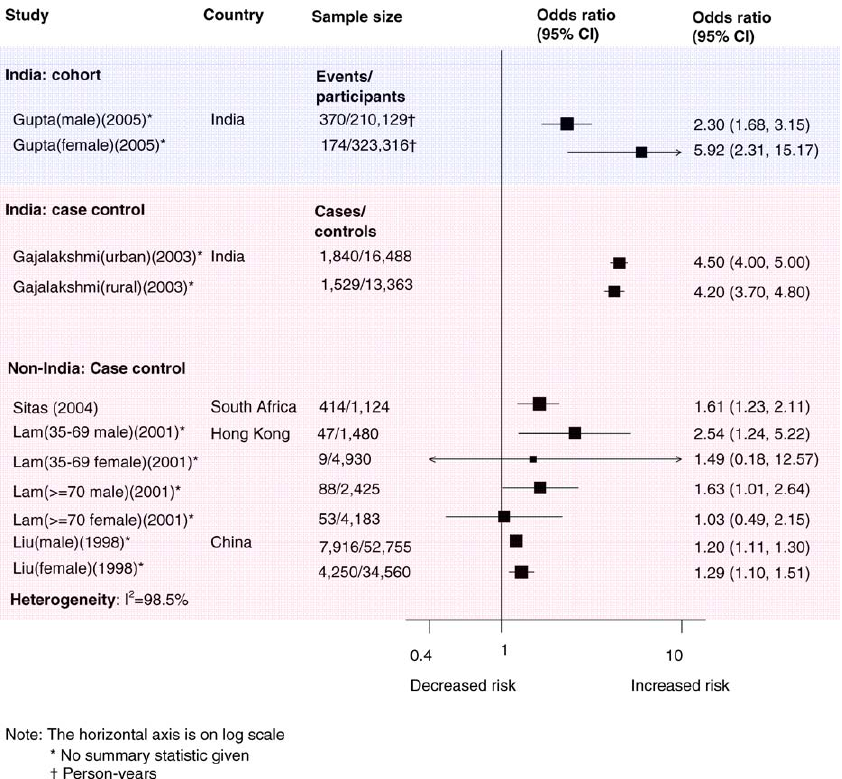
Figure 6. Risk of Mortality Due to TB for Smoking Compared with Nonsmoking